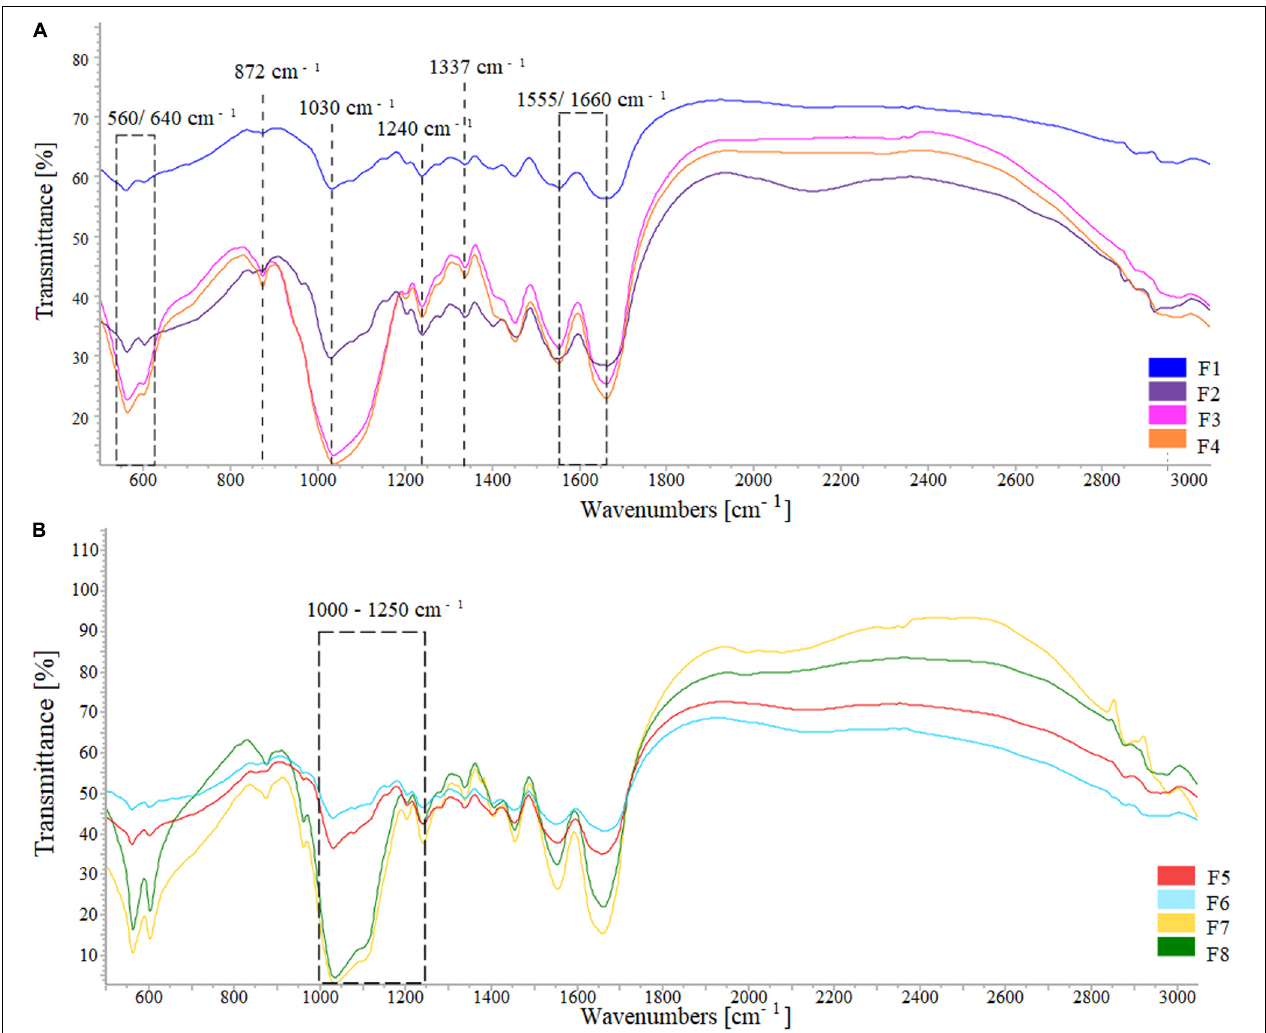
FIGURE 4 | FTIR spectra of (A) the formulations HA/collagen and (B) the formulations HA/collagen after ribose